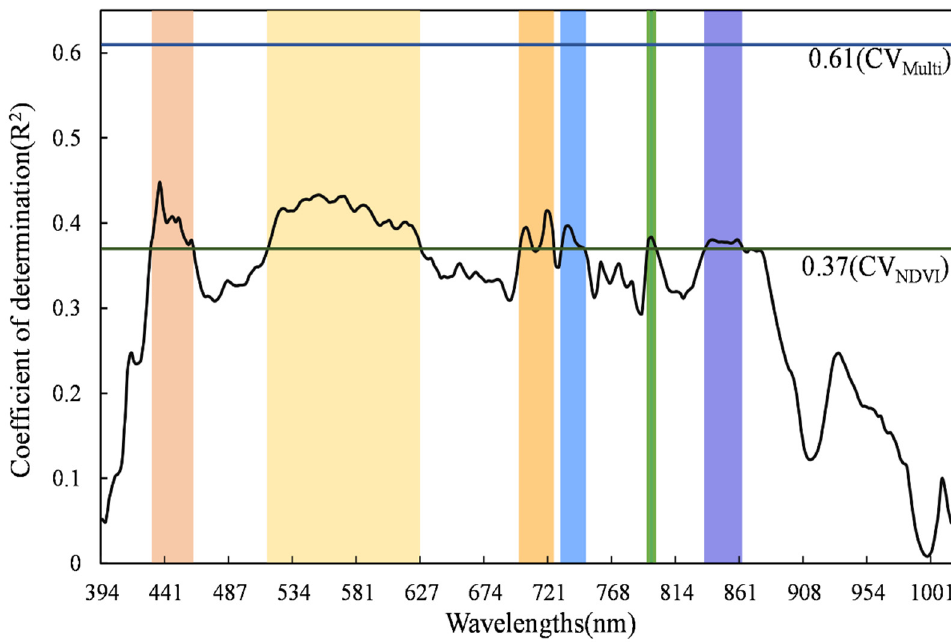
Figure 6. The coefficient of determination (R 2 ) of Shannon-Wiener index and CV calculated by each single band from 390 nm to 1020 nm, R 2 = 0.61 (CV Multi ) and 0.37 (CV NDVI ) were tagged as blue and green horizontal